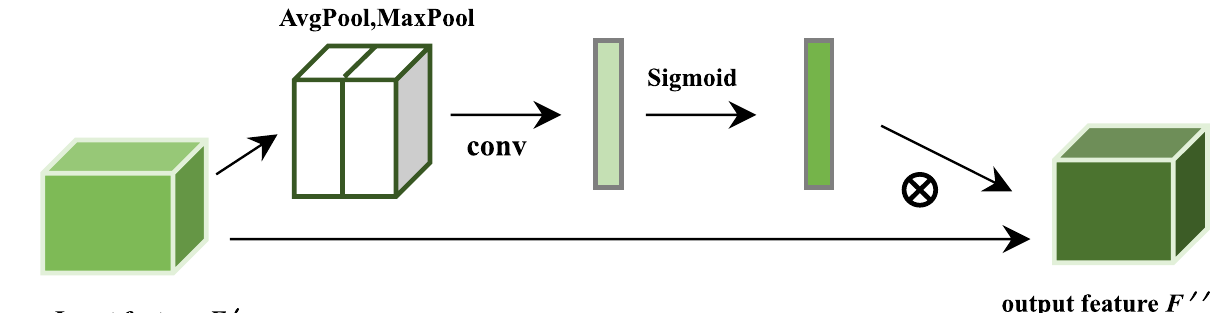
Fig. 3 Structure diagram of channel attention module [the circle shows the attention network]